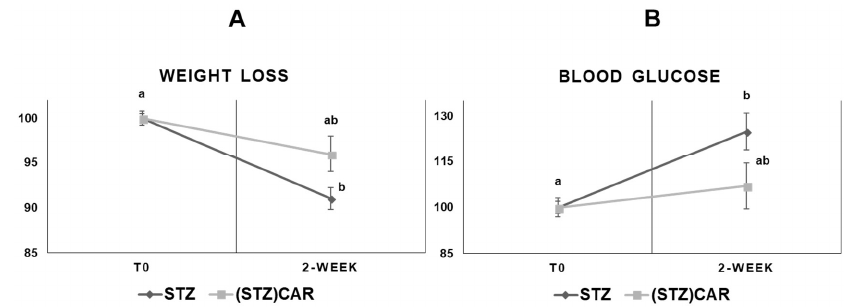
Figure 1. Weight loss ( A ) and blood glucose levels ( B ) in mice that underwent STZ treatments in the absence and presence of CAR oral administration. Relative (%) weight and blood glucose concentrations after two weeks from overt hyperglycemia [T0, 100%]. Overt hyperglycemia refers to the condition of STZ-treated mice showing sustained blood glucose concentration ≥ 250 mg/dL for at least seven days (see Materials and Methods section 4.1). STZ: STZ-treated, hyperglycemic mice; (STZ)CAR: STZ-treated mice underwent a two-week CAR administration (1 g/L in drinking water). Values refer to the mean (±S.E.M.) of n = 5 individuals. Statistical analysis: t -Student; different letters indicate significantly different values ( p < 0.05).